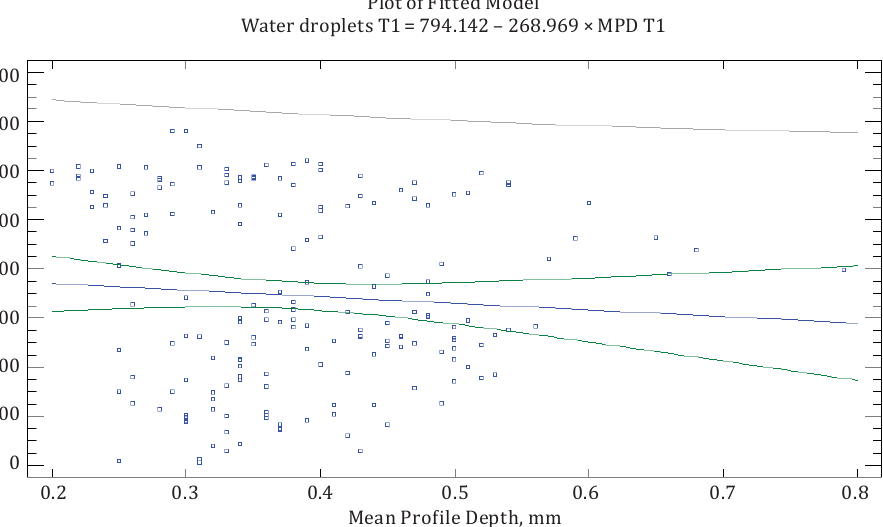
Figure 8. Number of water droplets on Test Track 1